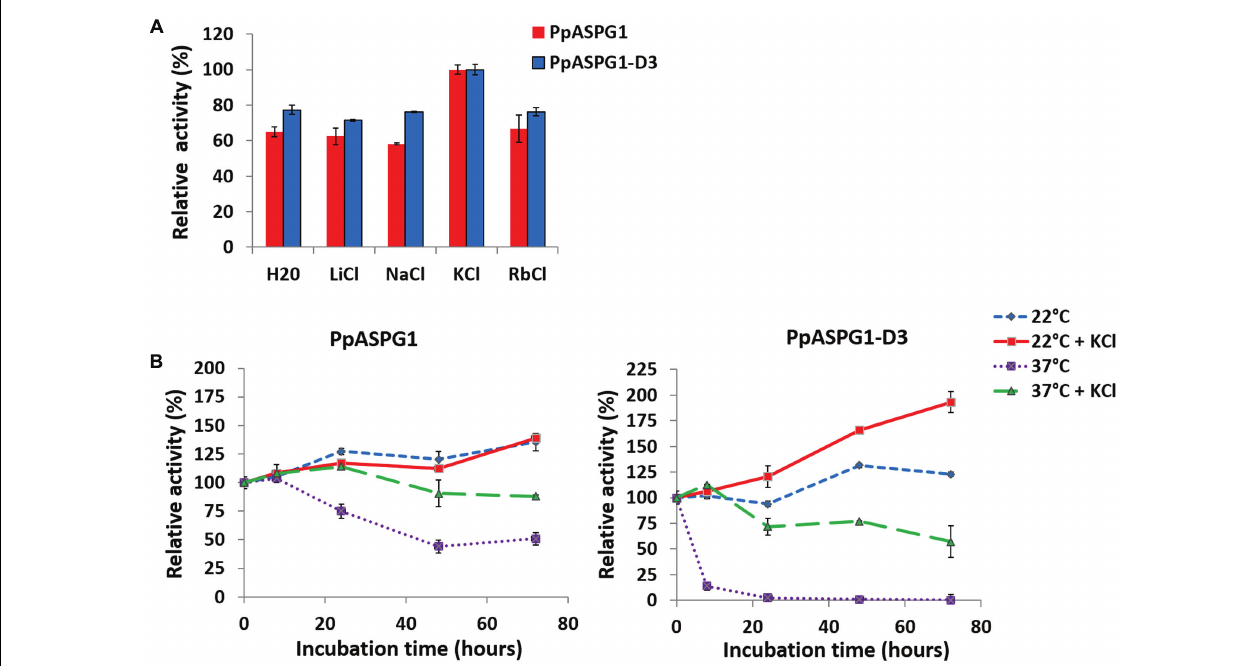
FIGURE 7 | Effect of monovalent cations on enzymatic activity and thermal stability of both PpASPG1 variants. (A) ASPG activity was measured for PpASPG1 and PpASPG1-D3 in a buffered medium containing 20 mM L -Asn and 50 mM of the corresponding chloride salt for each ion or water. Values are presented as the mean of three replicates ± SD. For both PpASPG1 and PpASPG1-D3, the activity values in the presence of KCl are significantly different of those in the different conditions assayed, according to t -tests ( p < 0.01). (B) Both protein variants were incubated during three consecutive days at 22 or 37 ◦ C in the buffered medium with or without the addition of 50 mM KCl. Aliquots were removed at different time points and residual ASPG activity was assayed. Values are presented as the mean of three replicates ± SD. For PpASPG1, in the absence of KCl, the activity values were significantly different between 22 and 37 ◦ C from the measurements after 24 h of incubation, according to t -test ( p < 0.01). When KCl was present, the activity values are significantly different only at 48 and 72 h. At 22 ◦ C, there is not significantly differences in activity values at any incubation time between samples with or without KCl added. At 37 ◦ C activity values are significantly different between reactions with or without KCl added at 24, 48, and 72 h. For PpASPG1-D3, activity values are significantly different in the presence or absence of KCl at all incubation times both at 22 and 37 ◦ C, except at 8 h for 22 ◦ C, according to t -tests ( p < 0.01). Similarly, activity values after incubation at 22 or 37 ◦ C are significantly different at all incubation times both in the absence or presence of KCl, except at 8 h with